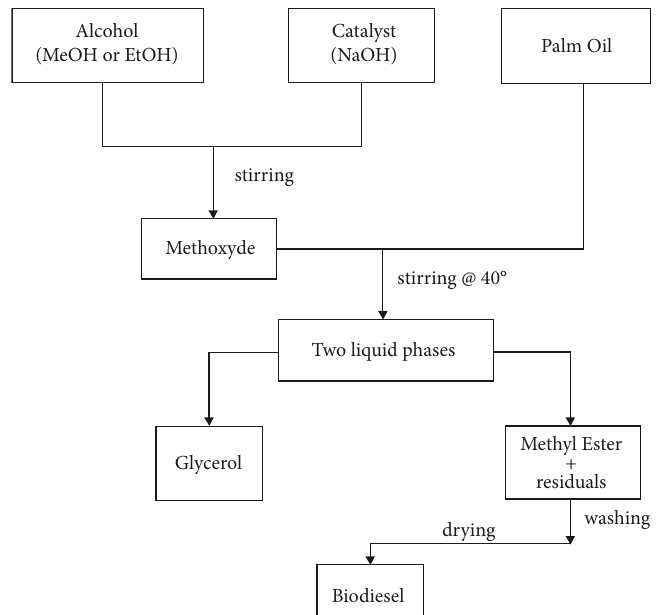
Figure 1: Schematic diagram of the transesterification process.